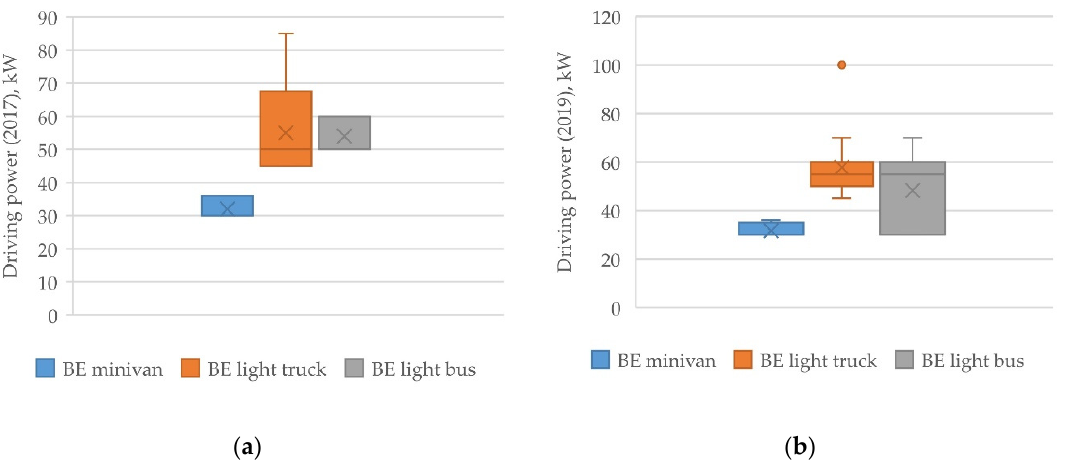
Figure 10. Driving power distribution of the various BELVs, ( a ) 2017 and ( b ) 2019.